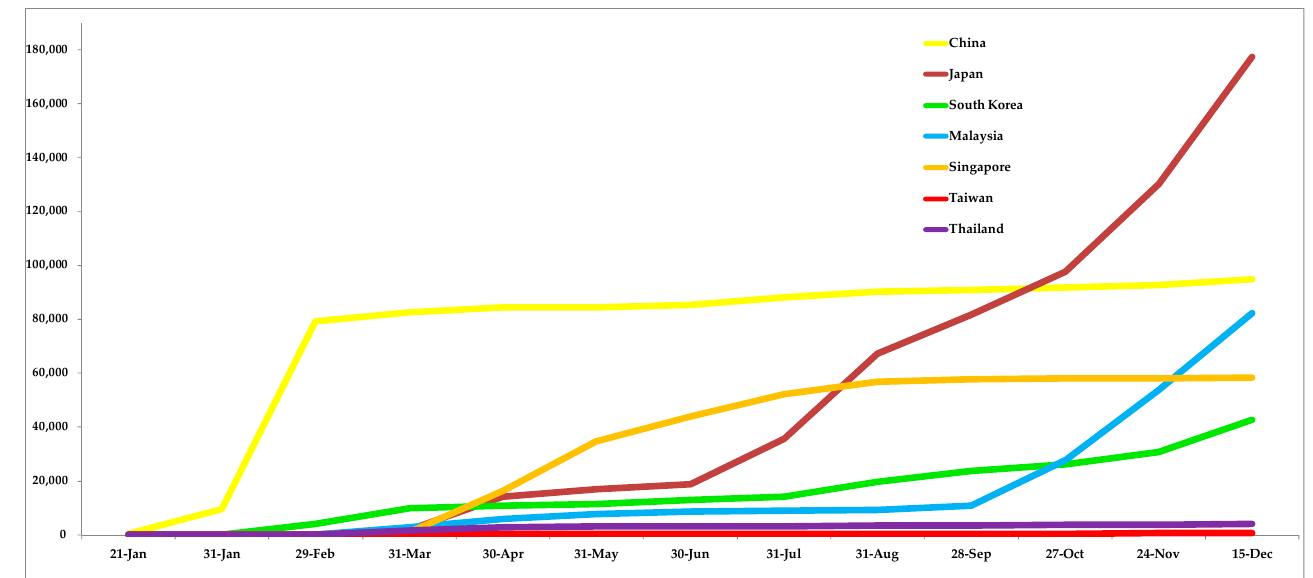
Figure 1. Cumulative number of confirmed COVID-19 case in Taiwan and neighboring countries [7]. Table 2. COVID-19 incidence, mortality, and testing rates of Taiwan and neighboring countries, with risk ratios of neighboring countries.